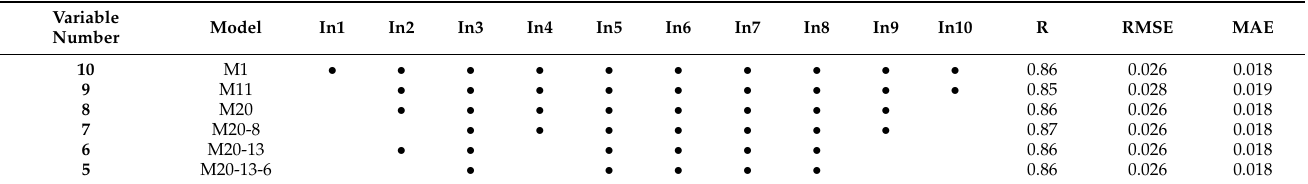
Table 6. The best models obtained with a decreasing number of bone curvature region variables.